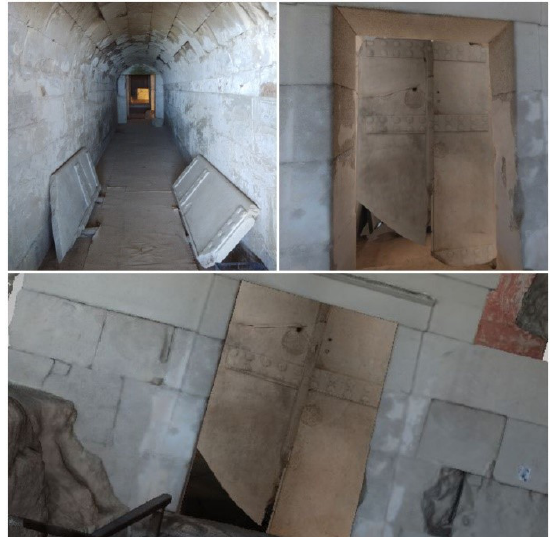
Figure 11: The virtual restoration of the marble door of the Macedonian tomb of Heuzey